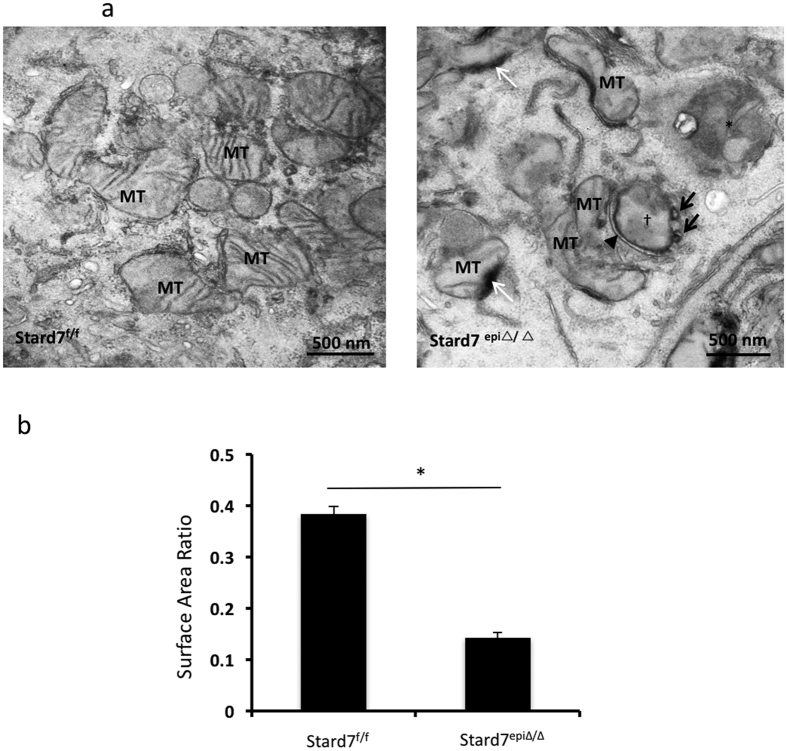
Altered mitochondrial structure in airway epithelial cells of Stard7epiΔ/Δ mice.(a) Airway sections obtained from lungs of 4-month-old Stard7f/f and Stard7epiΔ/Δ mice were examined by electron microscopy. Stard7epiΔ/Δ mice exhibited mitochondrial abnormalities in bronchiolar epithelial cells, including poorly defined mitochondrial matrix, reduction in number of cristae, increased lipid accumulation juxtaposed to outer limiting membrane of mitochondria (white arrow), formation of mitochondrial blebs (black arrow), and mitochondrial disintegration. Formation of an isolation membrane (small arrow) encircling a mitochondria (cross) and autophagosomes (asterisk) containing mitochondrial fragments were pronounced in some Stard7KO cells. (b) Electron micrographs of mitochondria in ciliated bronchiolar epithelial cells, acquired from 4-month-old Stard7f/f and Stard7epiΔ/Δ mice, were used for morphometric analysis. There was a significant reduction of mitochondrial cristae in ciliated bronchiolar epithelial cells of Stard7epiΔ/Δ mice compared to Stard7f/f mice, **p < 0.001; MT = mitochondria.